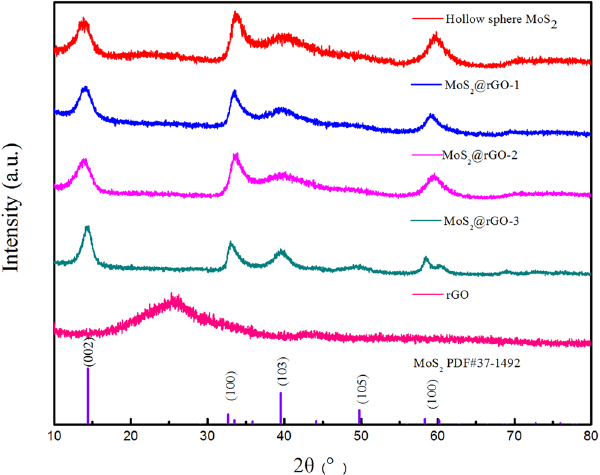
Figure 1. XRD patterns of the prepared rGO, pristine MoS 2 , and MoS 2 @rGO